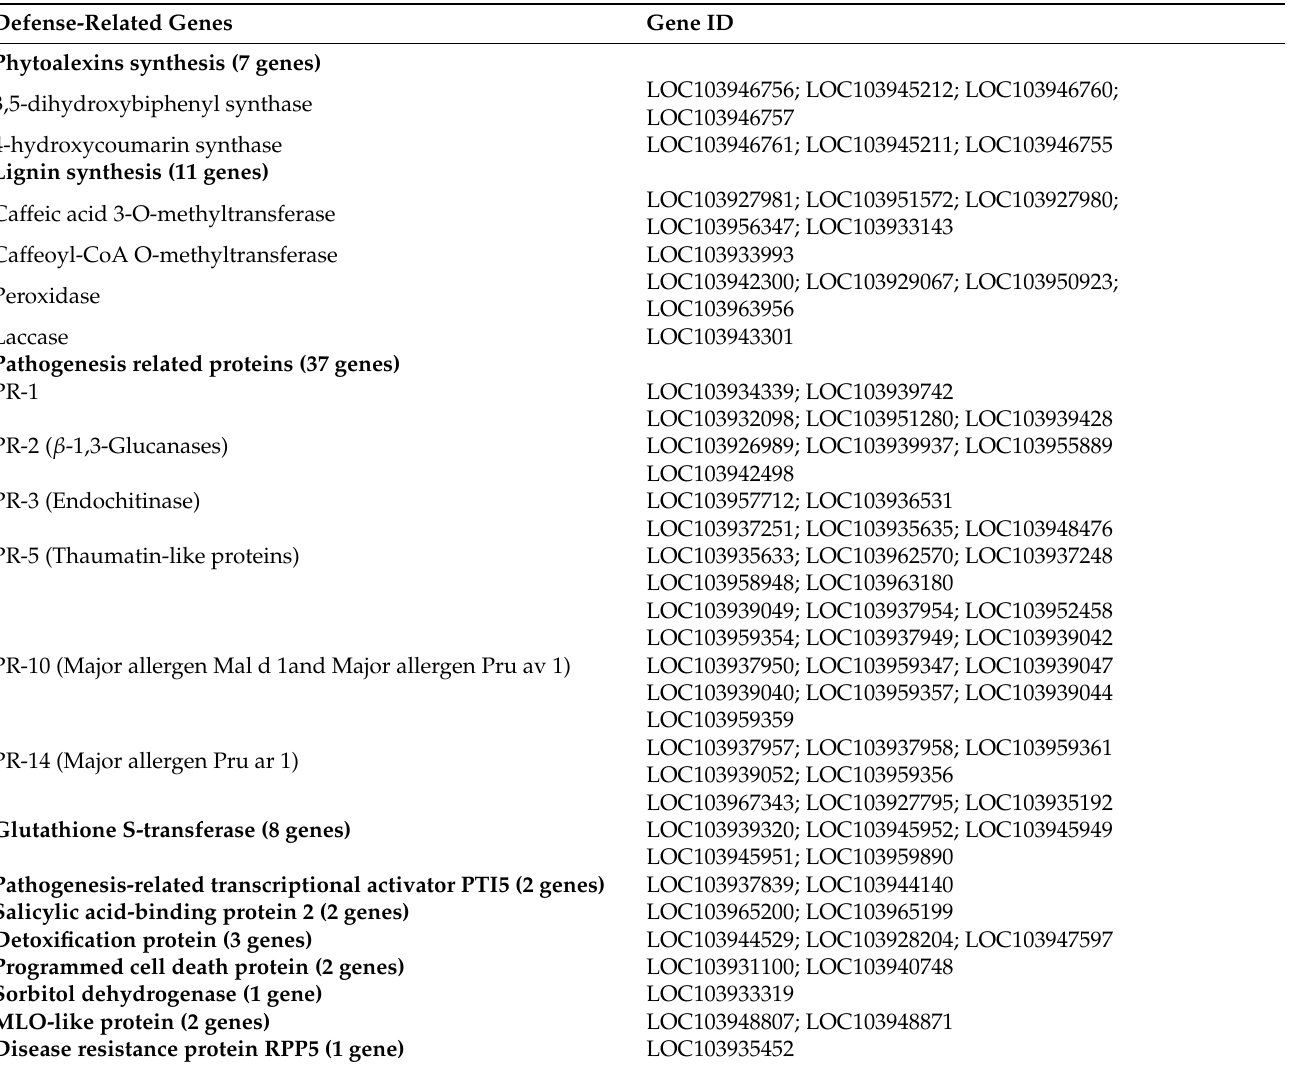
Table 1. Classification of defense-related genes in the ‘Yellow’